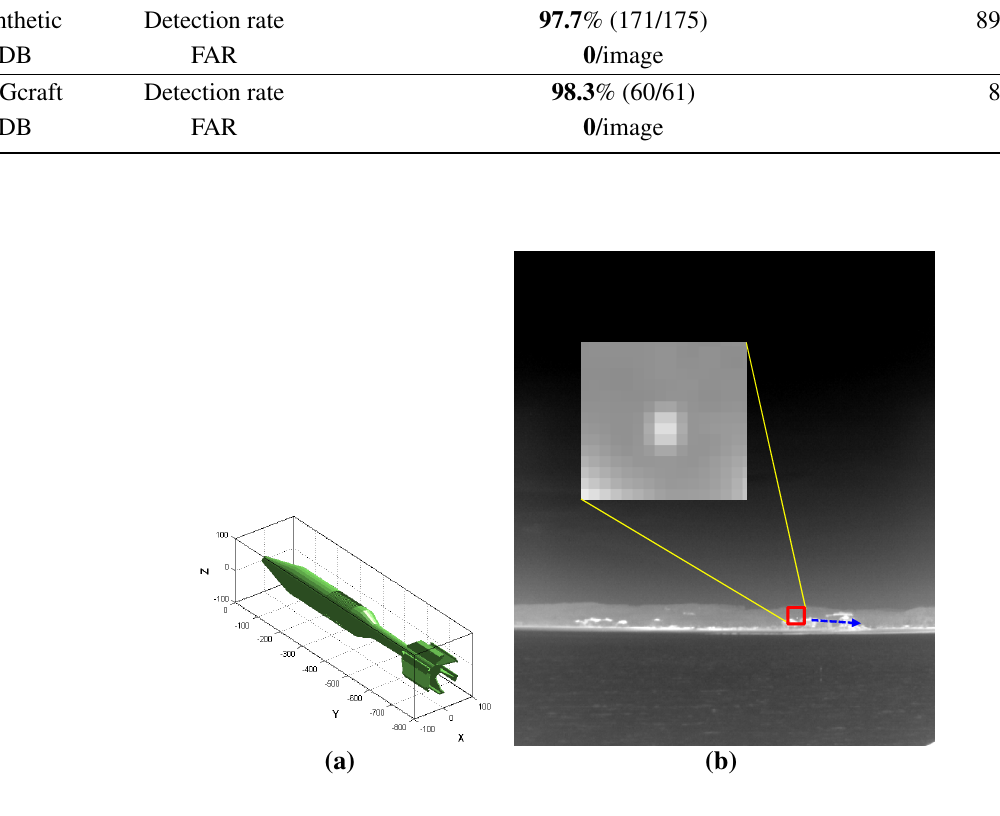
Figure 25. Generation of synthetic test images by inserting a 3D CAD model into the coast background image [36]: ( a ) 3D CAD model of a missile; ( b ) generated infrared image with the target